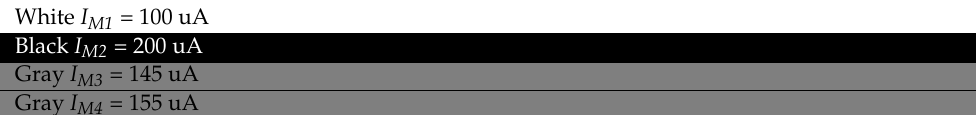
Table 4. The example of input pattern with two gray pixels with “large” frequency